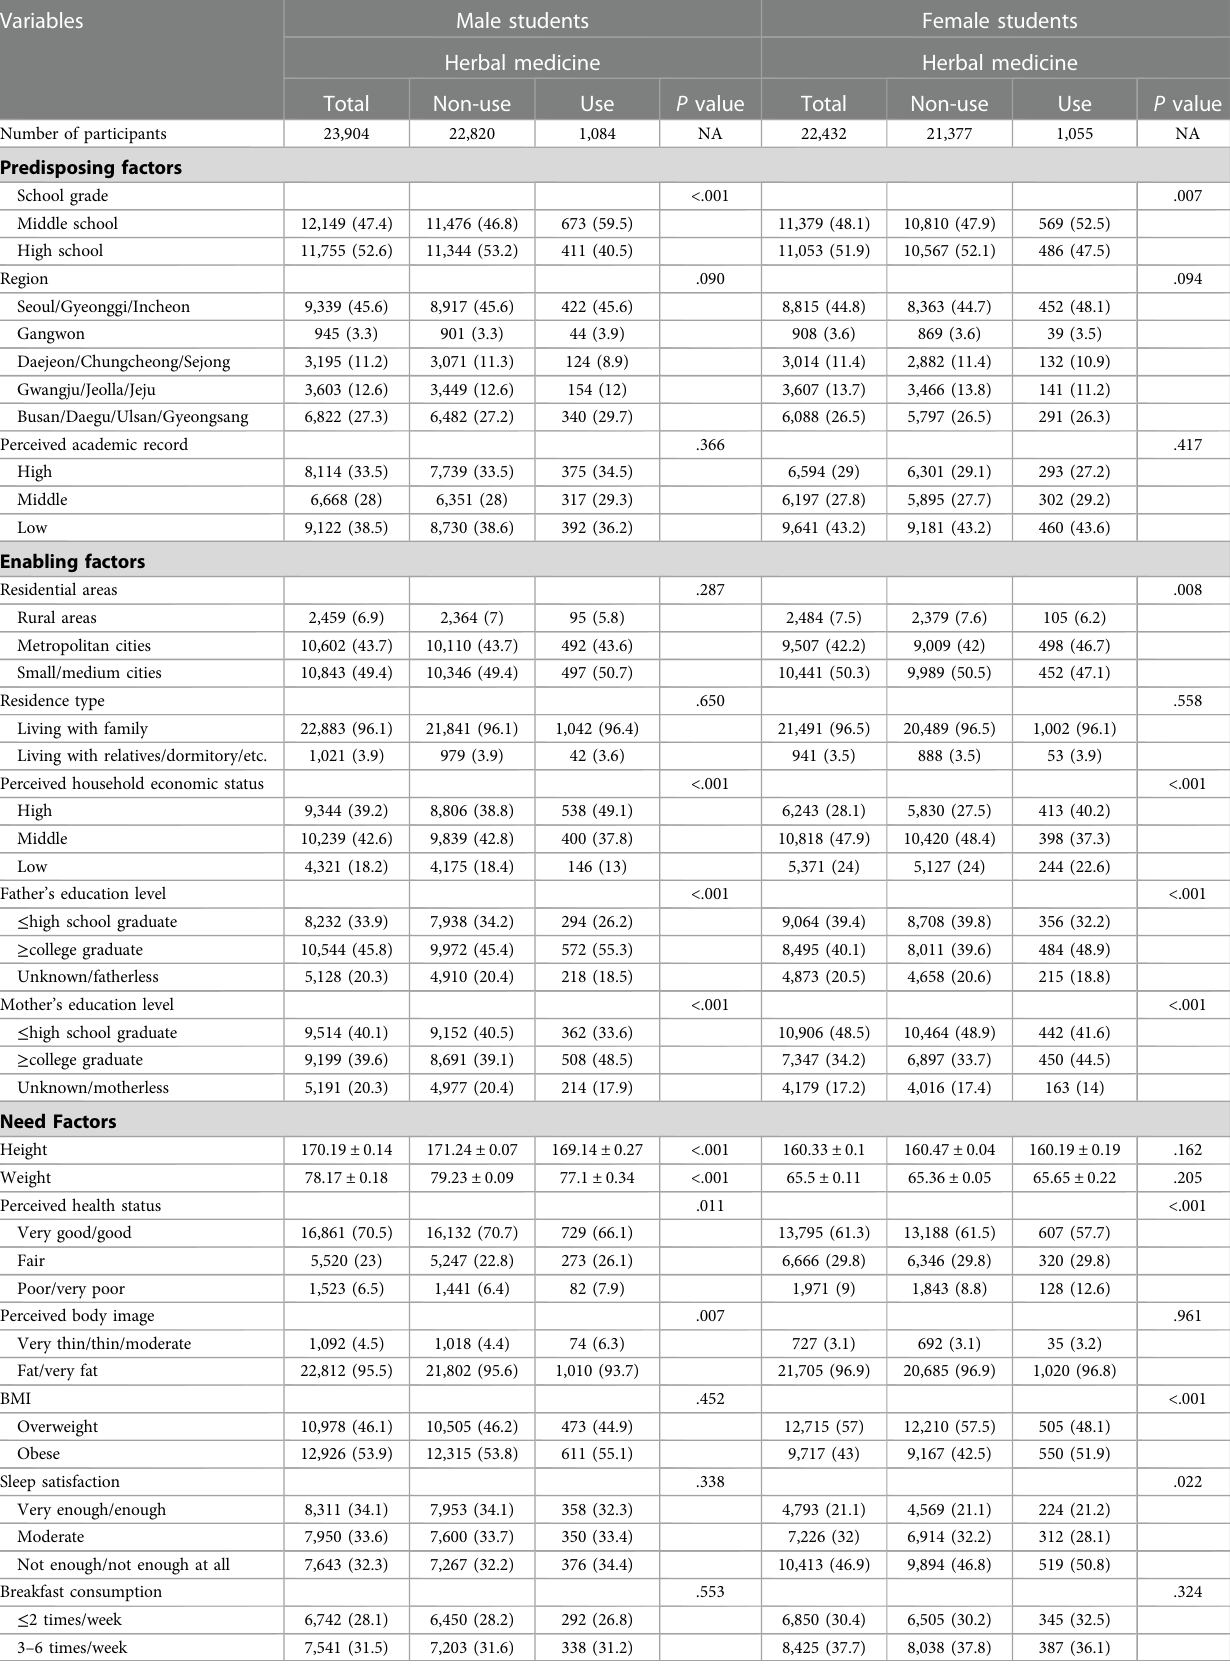
TABLE 1 General characteristics of participants between herbal medicine use and non-use groups.